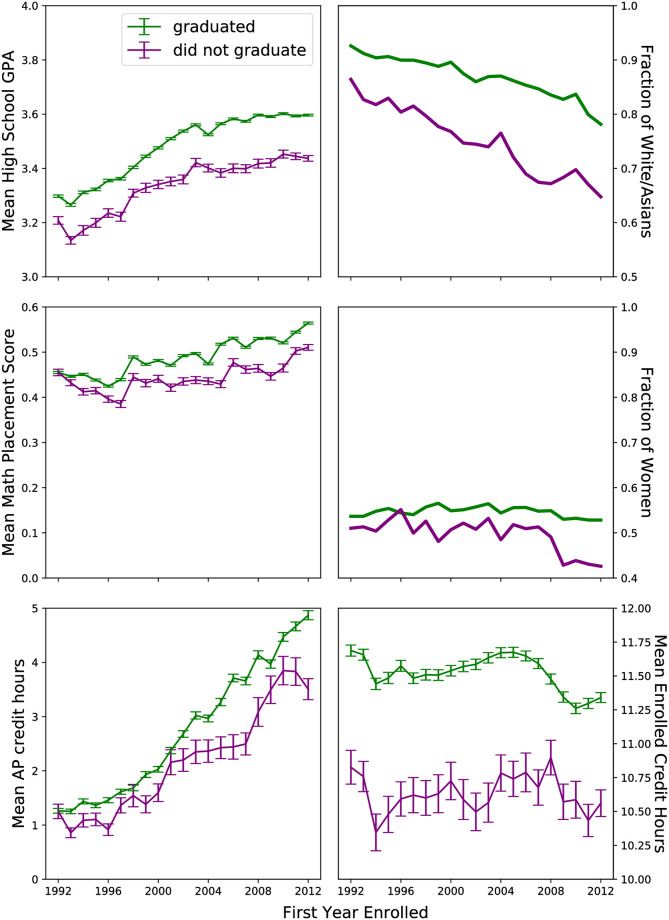
A comparison of a subset of features for students who graduate versus those who do not based on first year enrolled.Since 1992 the student population has become more diverse racially, students have had increasing high school GPAs and math placement scores, and the time it takes students who graduate to graduate has been decreasing. Students who graduate typically take more credit hours than those who don’t, typically are better prepared as measured by high school GPA and math placement score, and are less diverse than the total university population.